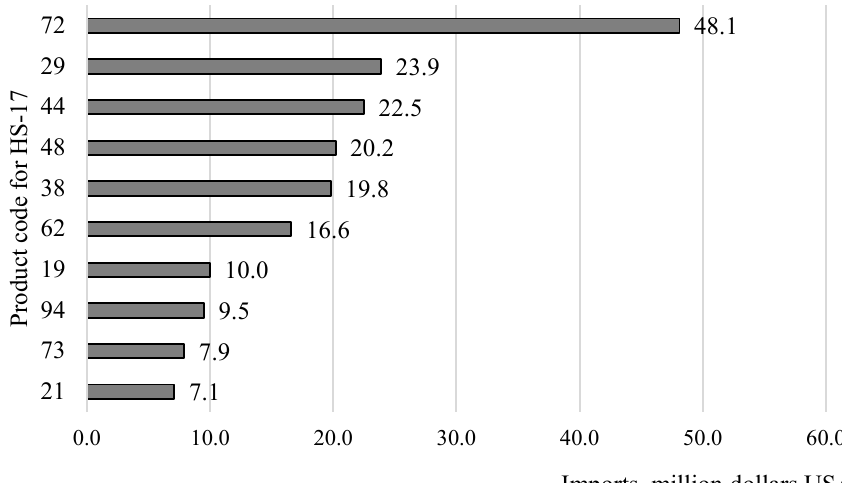
Fig. 4. Top 10 products imported to Latvia from Ukraine in 2021 (United Nations,